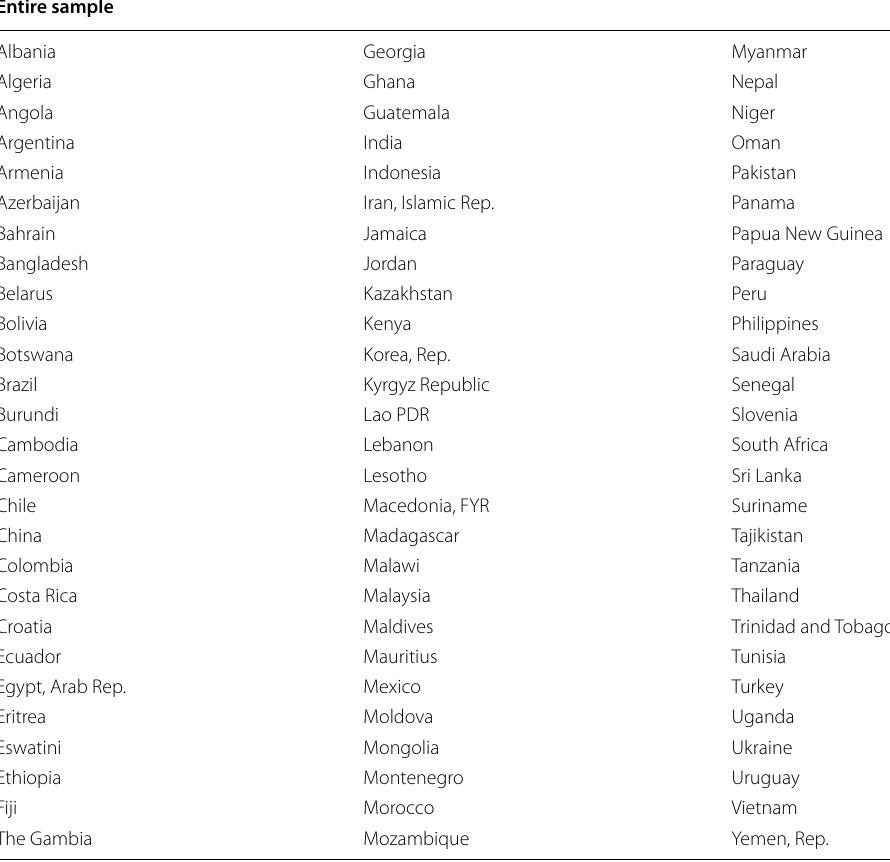
Table 8 List of countries contained in the full sample Entire